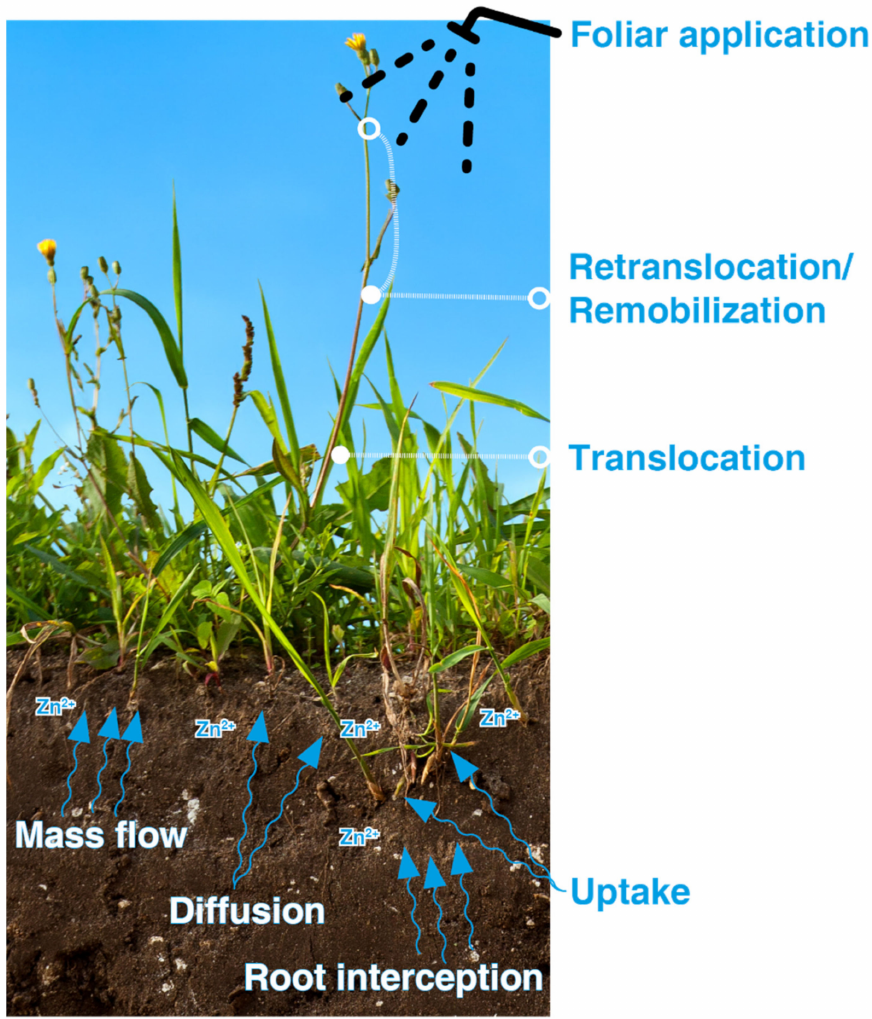
Figure 2. Uptake, translocation, and remobilization of Zn in